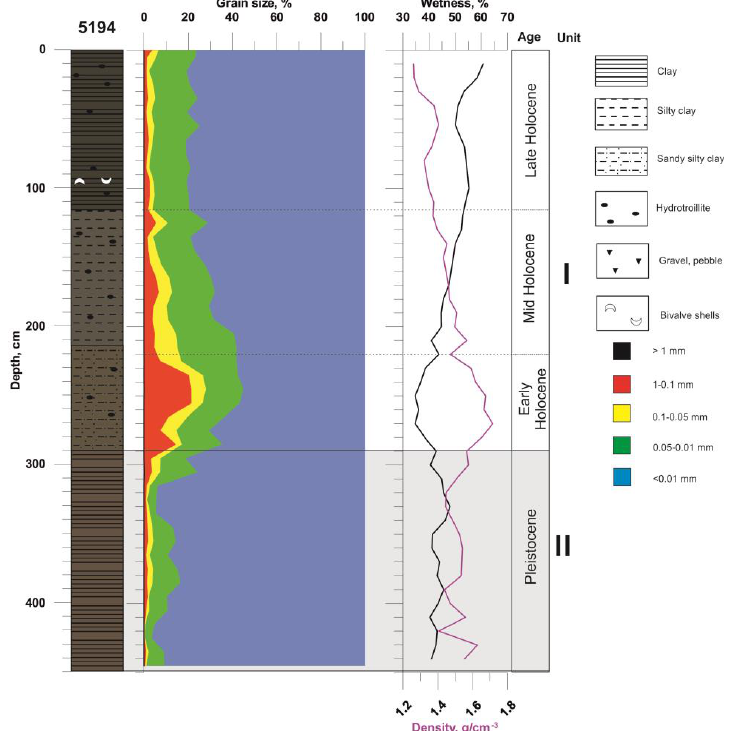
Figure 2. The lithology, grain size distribution, density, wetness, approximated age, and stratigraphic subdivision of the AMK-5194 sediment core, Central Deep of the Barents